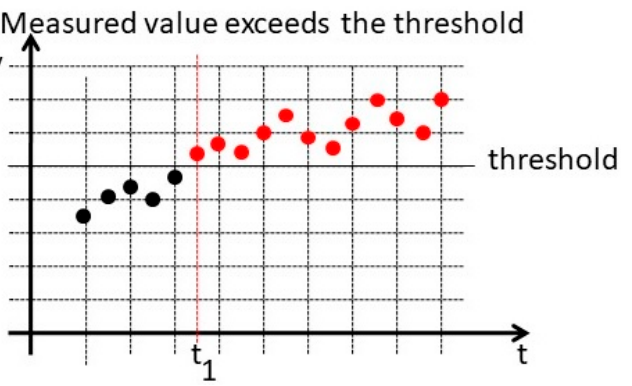
Figure 1. Measured value that exceeds the threshold: Values ‘V’ below and above the threshold.